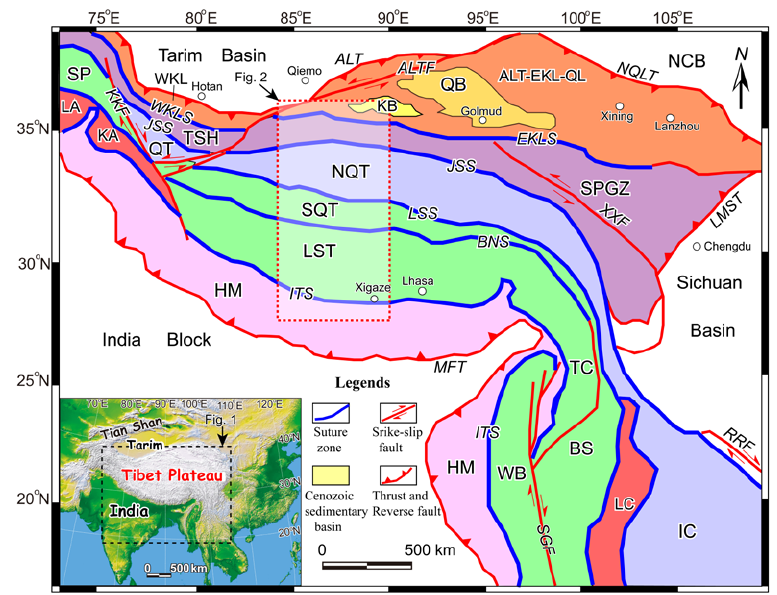
Figure 1. Simplified tectonic map of Tibet and surrounding region, showing the main suture zones in Tibet (modified from References [26–28]. Blocks and terranes : ALT-EKL-QL: Altyn